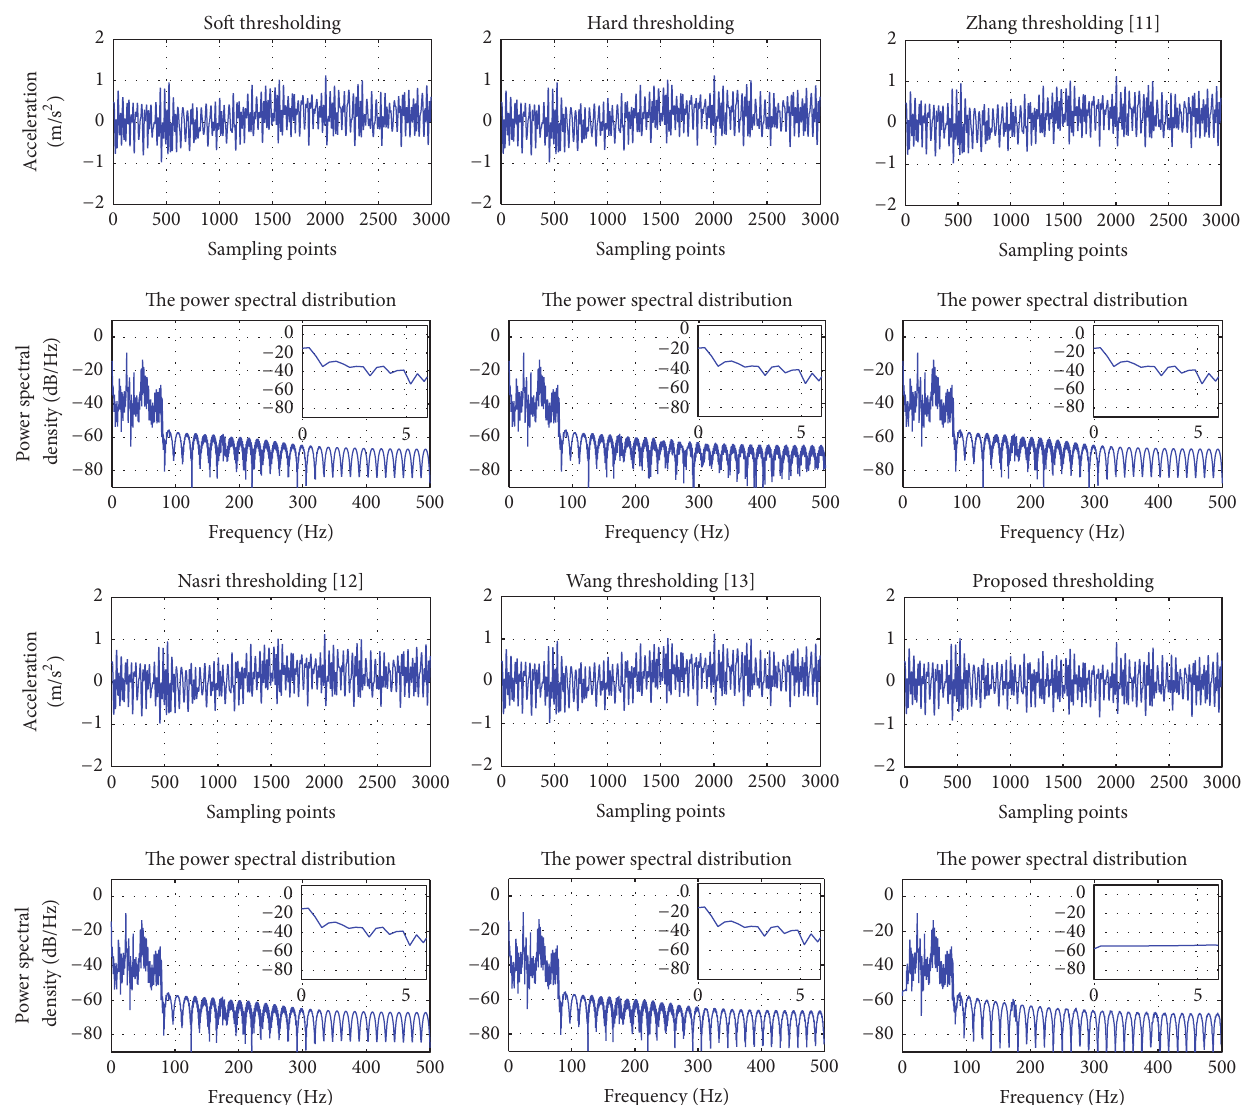
Figure 15: The denoised results of